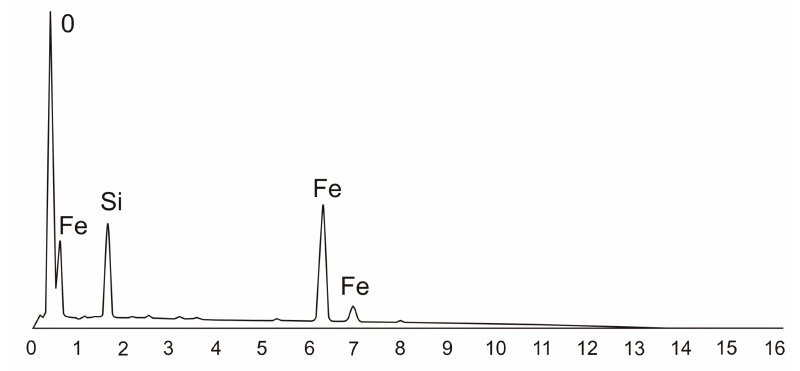
Figure 4. EDS point analysis of the area marked in Figure 2